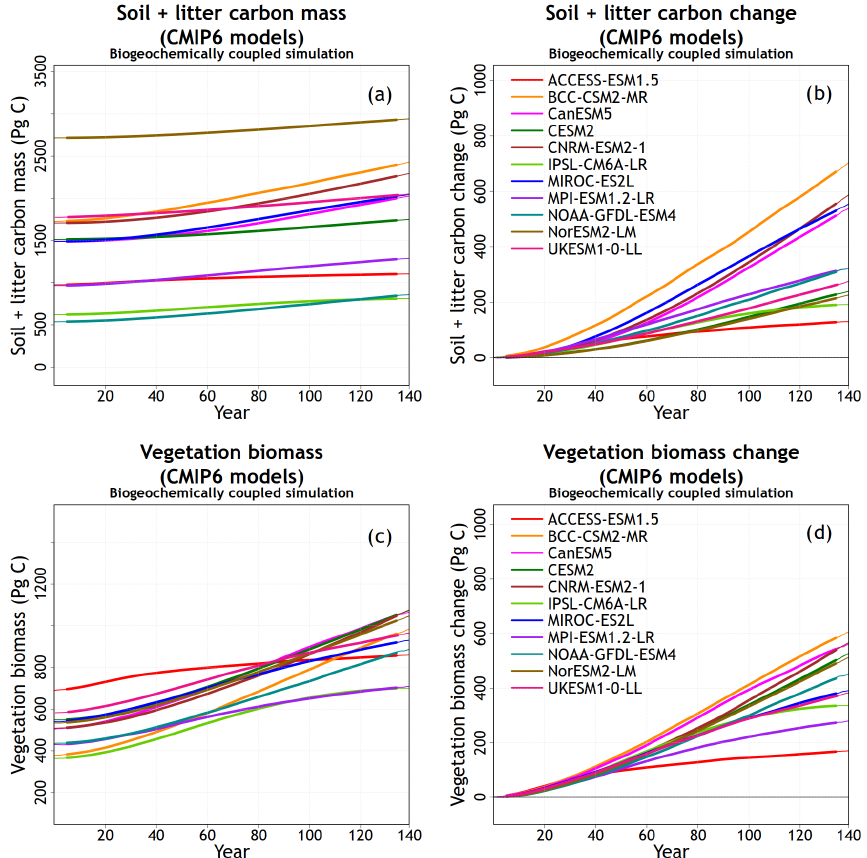
Figure A3. Absolute amounts and the change from the beginning of the BGC simulation for carbon in soil + litter (a, b) and vegetation (c, d)